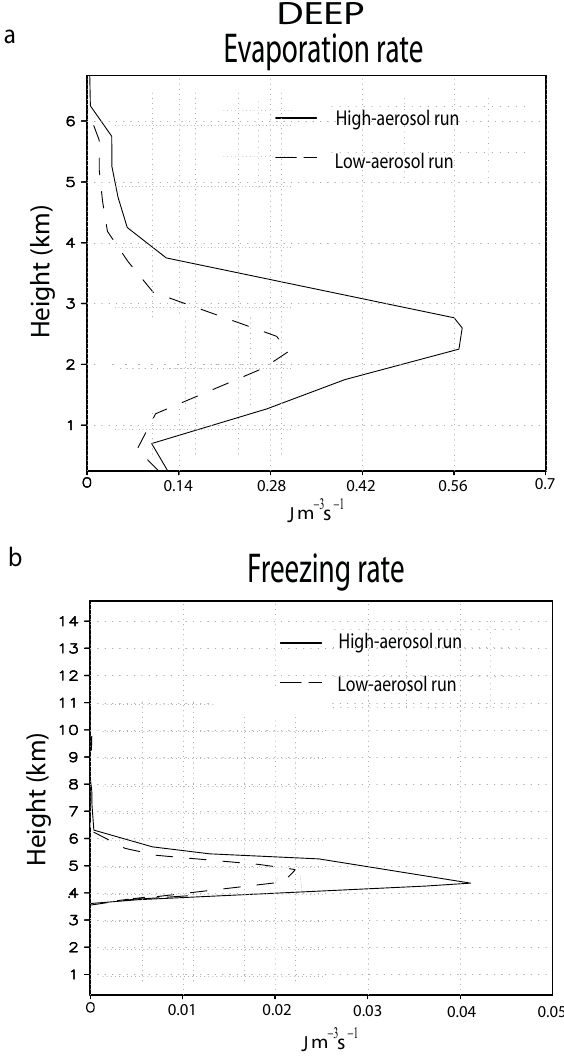
Fig. 5. Time- and domain-averaged vertical distribution of the rate of latent-heat changes due to (a) evaporation and (b) freezing for DEEP.